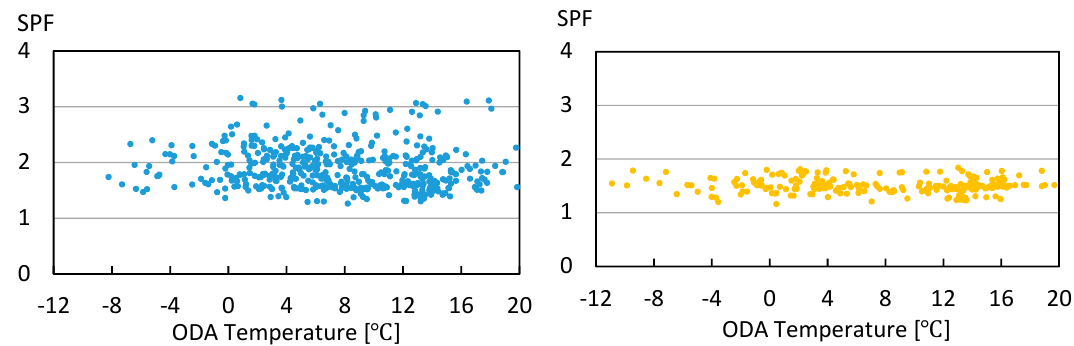
Figure 27. Daily SPF 3 + values for hot water plotted against outdoor air temperatures before ( left ) and after ( right ) the change of the thermostat setpoint temperature of the tank auxiliary heater.